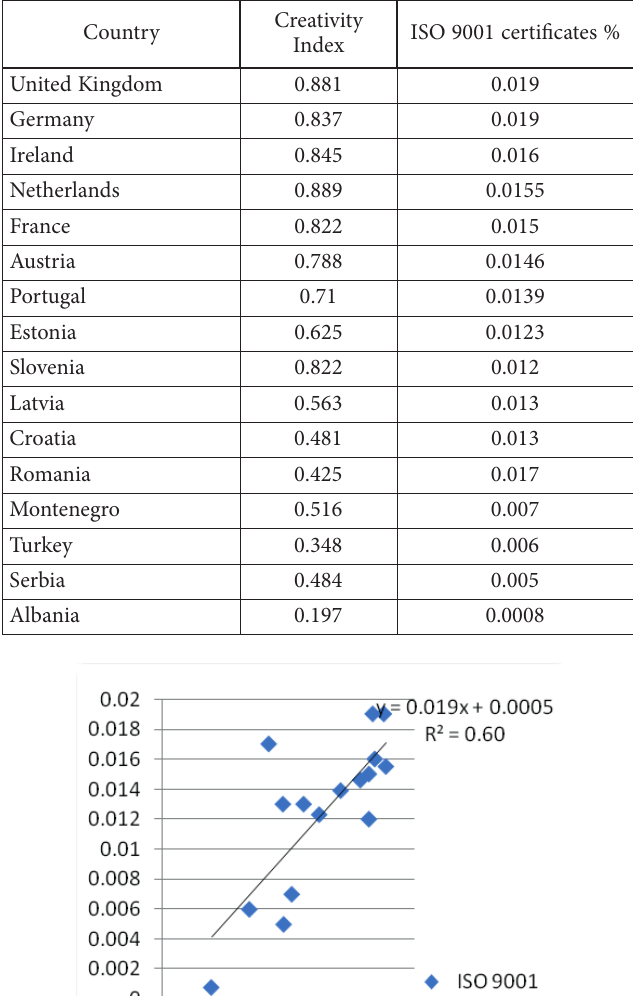
Table 2. Creativity index and ISO 9001 certifi cates per country (source: created by author)